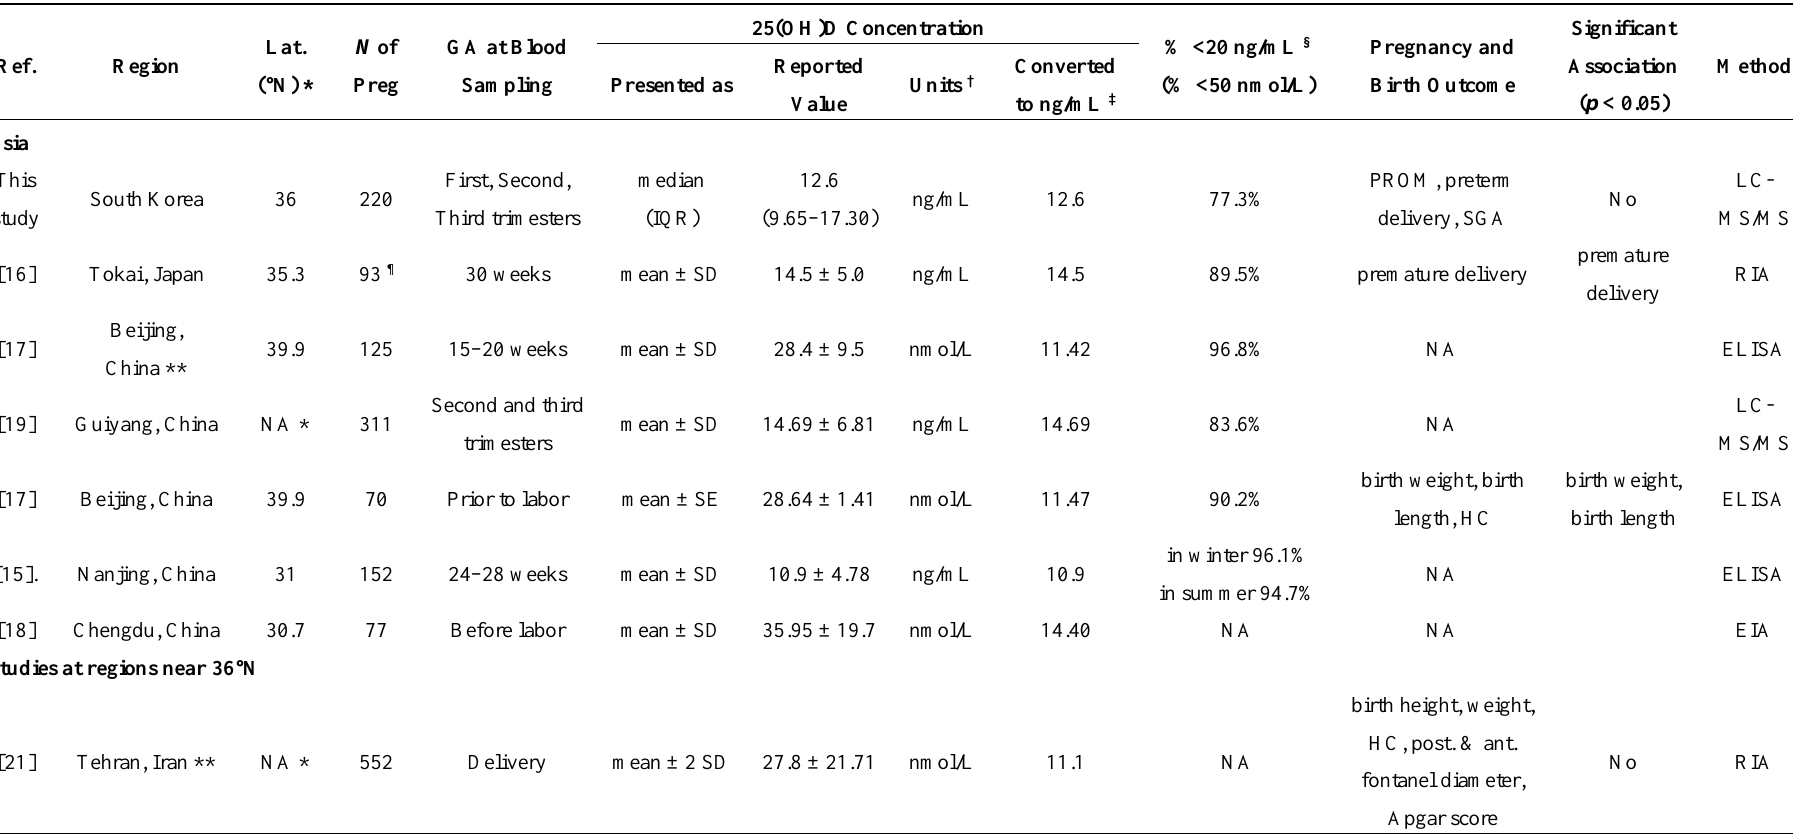
Table 6. Serum 25(OH)D concentrations in pregnant women in Asian populations and in regions at latitudes near 36°N. Ref.